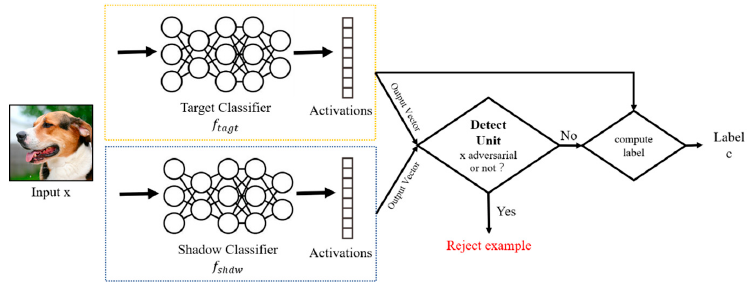
Figure 4. Architecture of the TwinNet framework.